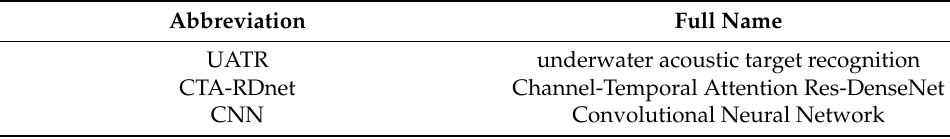
Table 7. List of